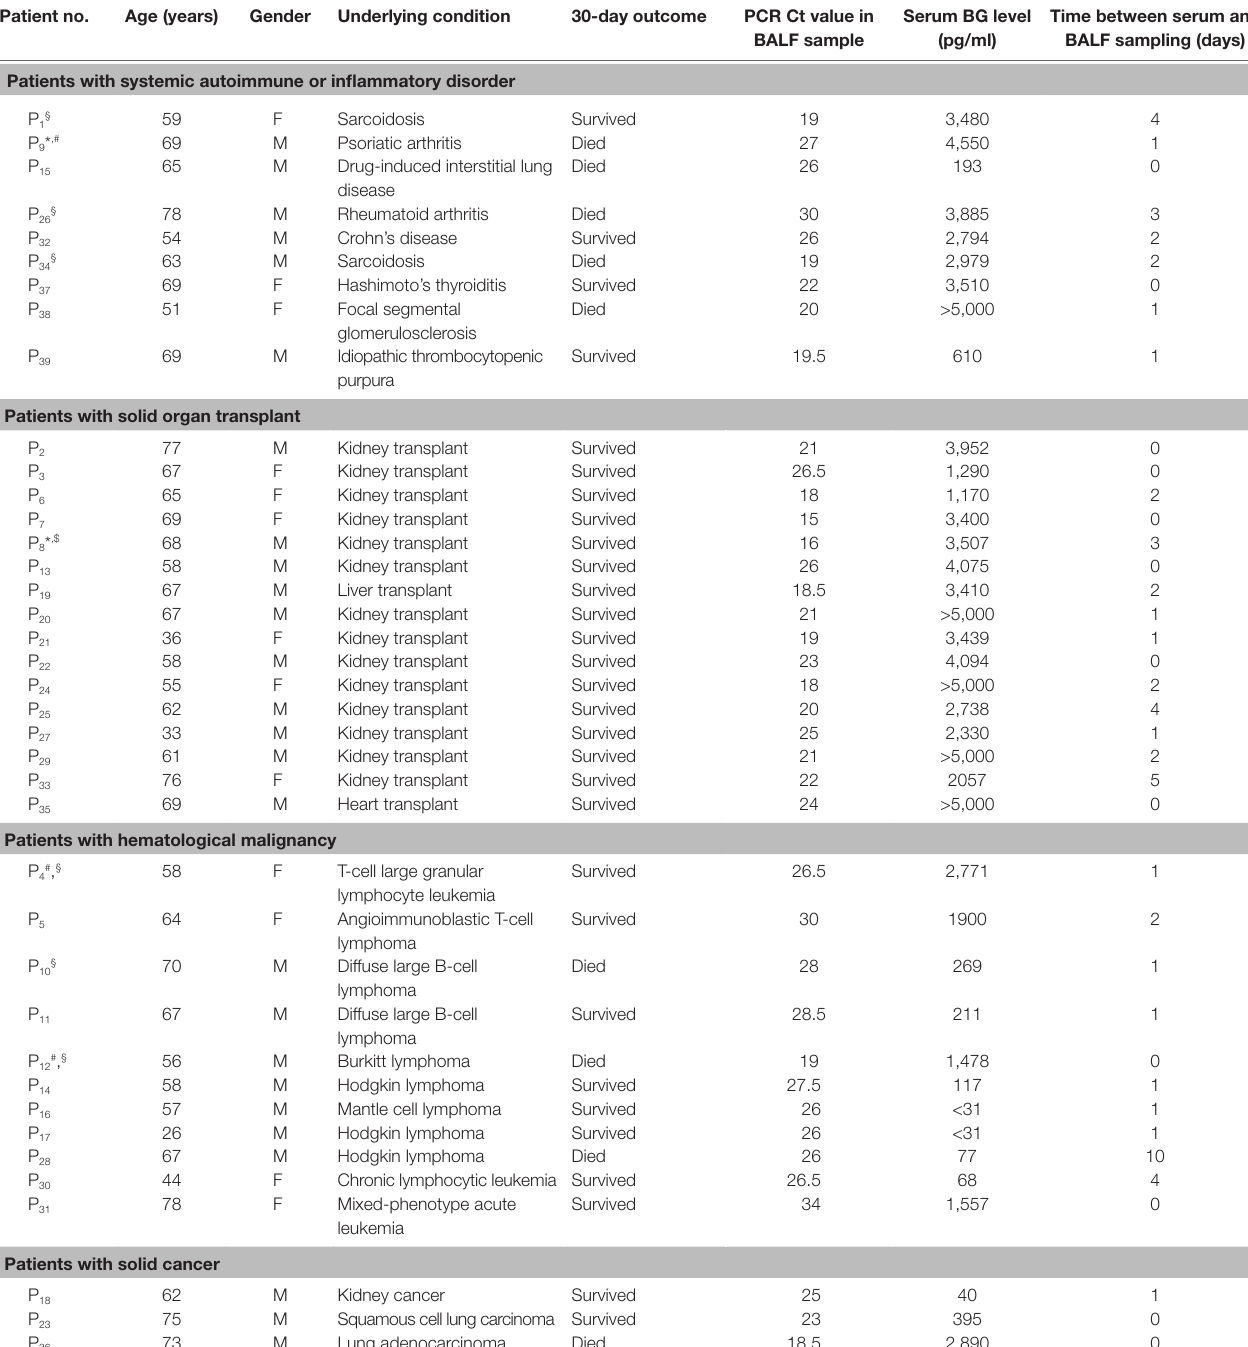
TABLE 1 | Characteristics of the 39 patients developing microscopically proven Pneumocystis pneumonia. Patient no. Age (years) Gender Underlying condition 30-day outcome PCR Ct value in